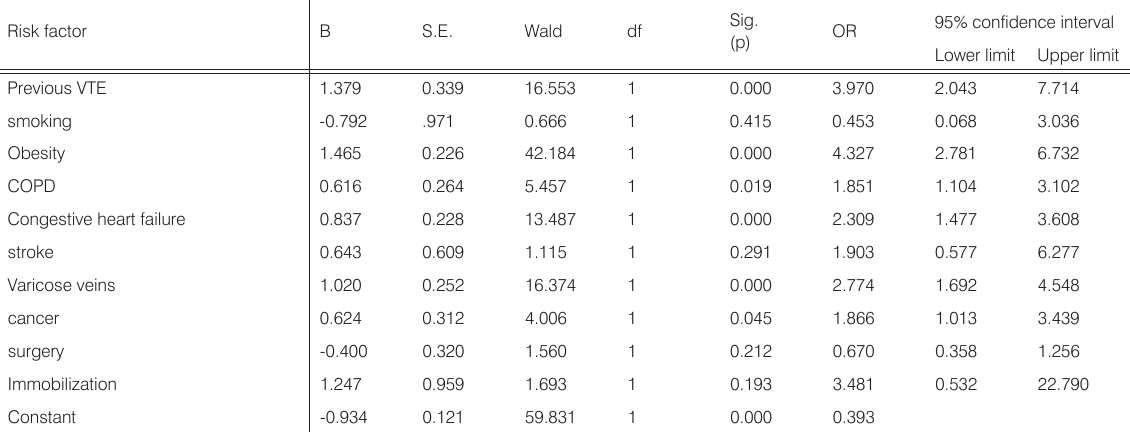
Table 4. Binary logistic regression to assess the independent risk factors for VTE Risk factor B